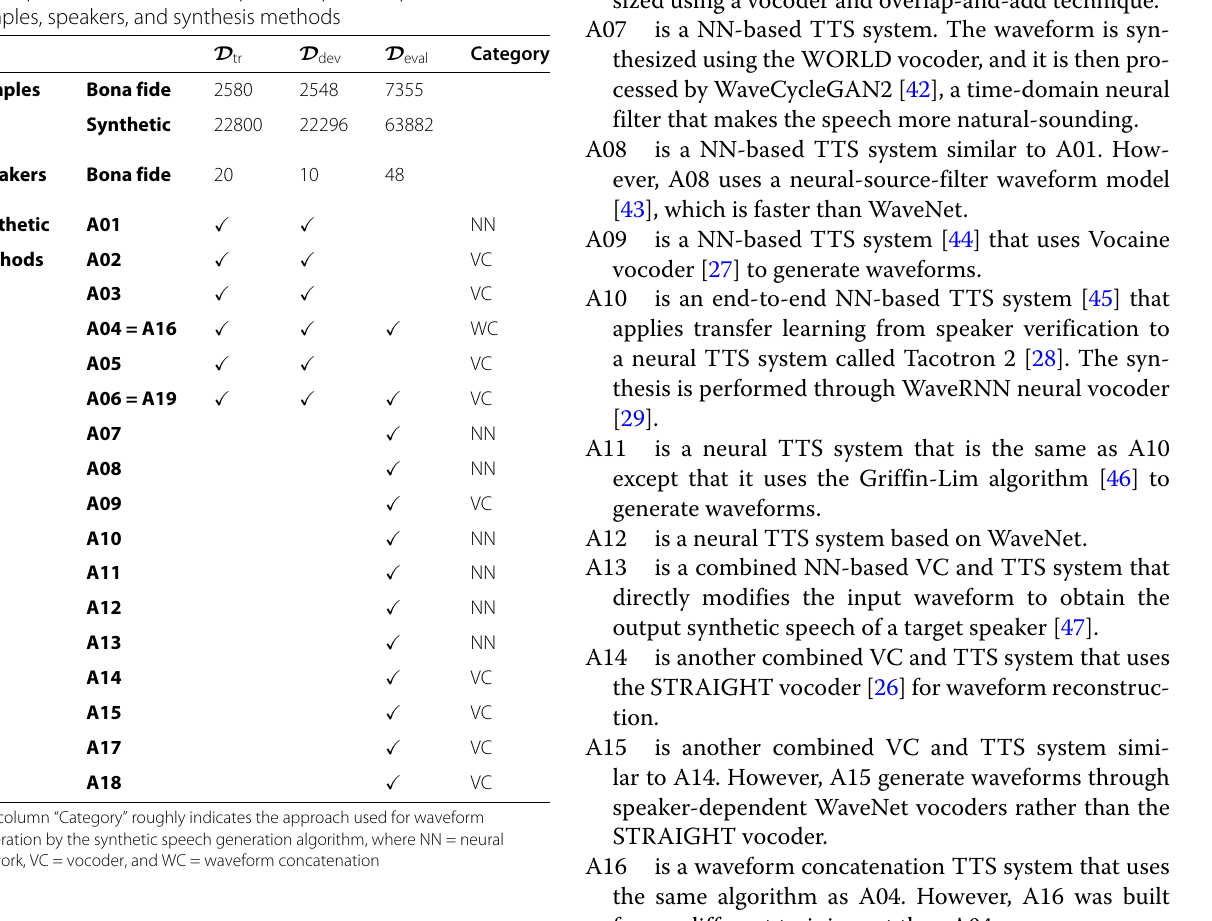
Table 1 Breakdown of the used dataset showing the training, development and evaluation splits composition per number of samples, speakers, and synthesis methods Samples Bona